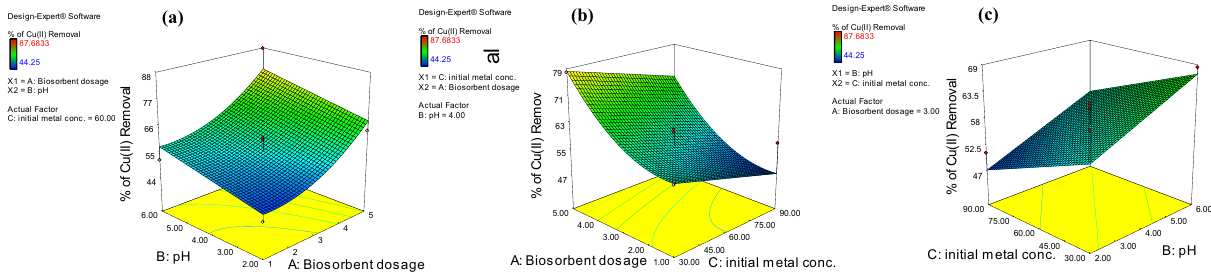
Figure 2. 3-D response surface plots for Cu 2+ removal showing the interaction influences of ( a ) biosorbent dose and pH, ( b ) biosorbent dose and initial copper concentration, and ( c ) pH and initial copper concentration.